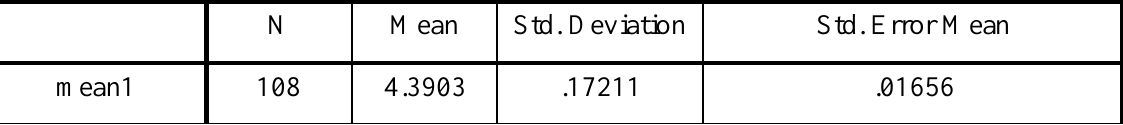
Figure 12. Descriptive statistics of the variable in sub-hypothesis A